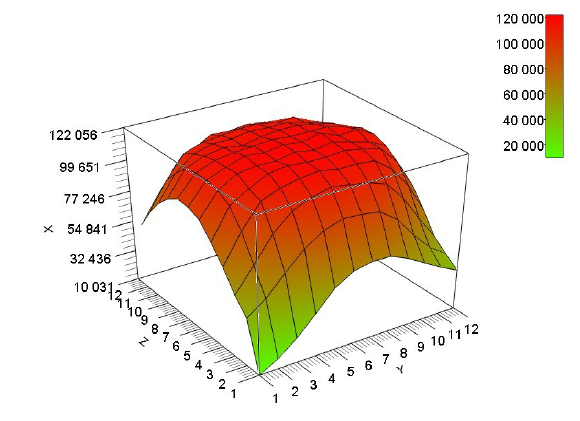
Figure 8. 3D graph of neutron flux